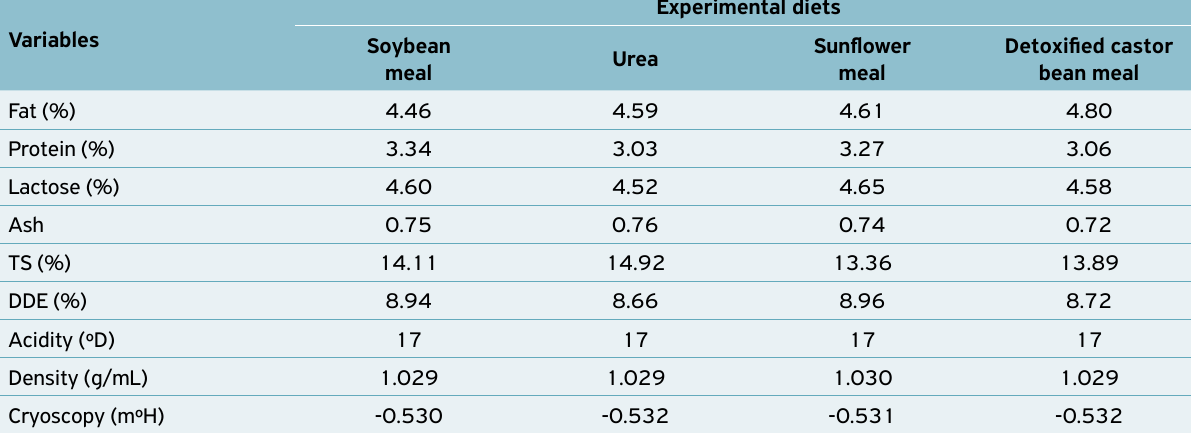
Table 2. Physical and chemical composition of milk used for processing Minas fresh cheese, according to different experimental